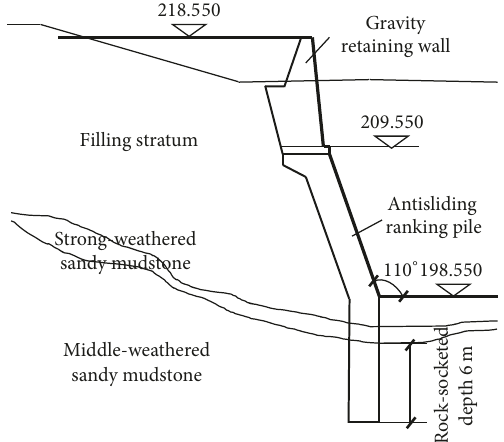
Figure 6: The diagram of the balance of retaining wall.